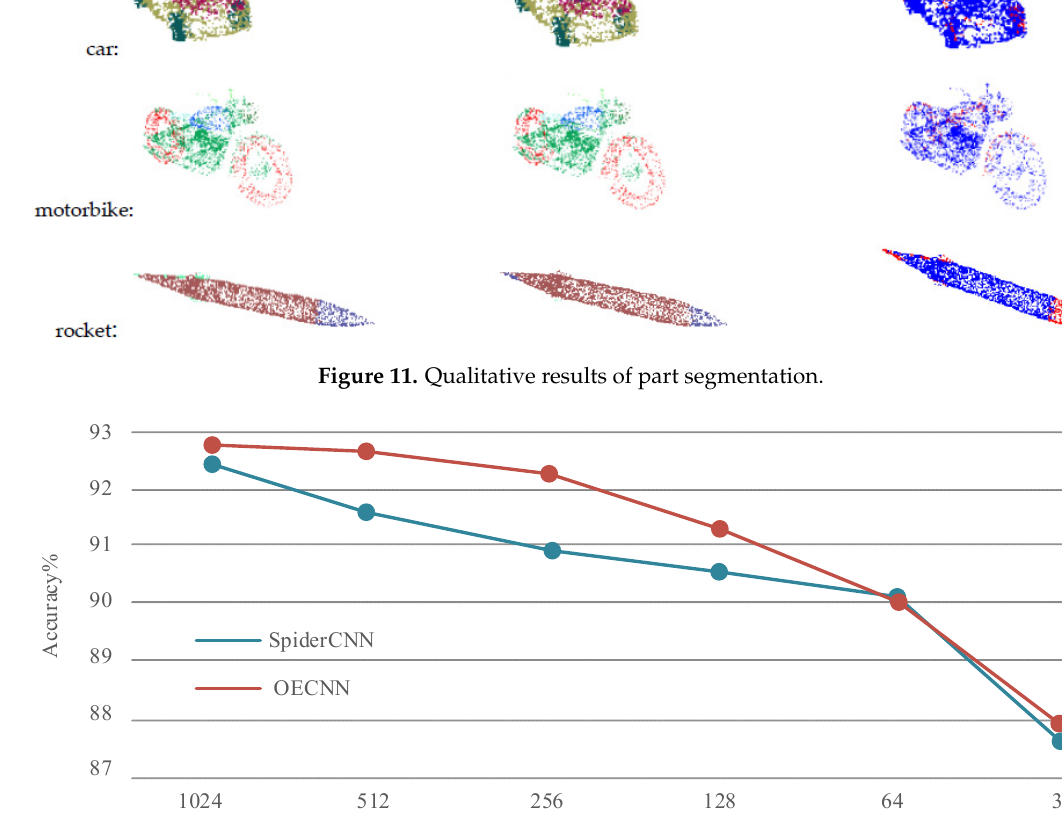
Figure 12. Classification accuracy of OECNN and SpiderCNN with different numbers of points as the input on ModelNet40 [20].